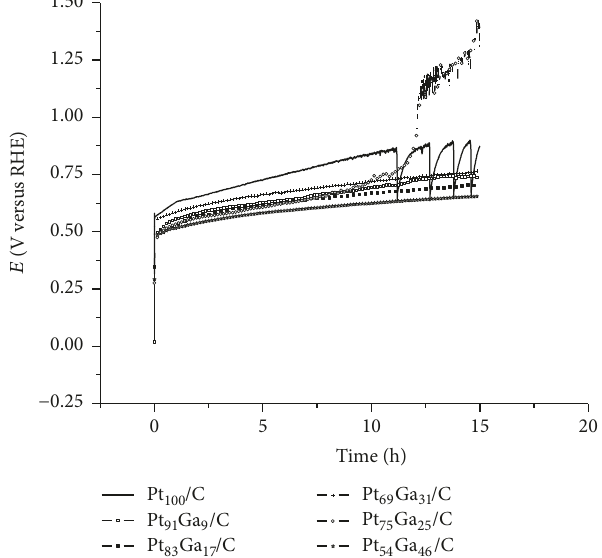
∗ Chi -square observed for all simulation ranged from 10 −4 to 10 −5 and the error for the data values simulation was obtained between 0.08 and 15 % . 𝑄1 is constant phase element; 𝑅1 is ohmic resistance; 𝑅2 is charge transfer resistance; 𝑊1 is Warburg impedance.